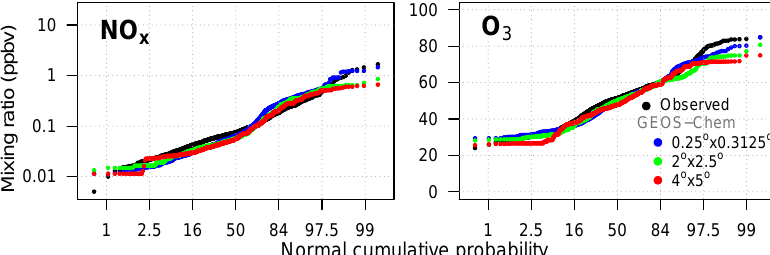
Figure 7. Cumulative probability distribution functions (CDFs) of NO x and ozone (O 3 ) concentrations in the lower free troposphere over the Southeast US (from mixed layer top to 4km altitude) during the SEAC 4 RS aircraft campaign. Observations are compared to GEOS- Chem model values at different resolutions sampled along the flight tracks over the Southeast US domain of Fig. 1. The x axis is a normal probability scale such that a normal distribution (ozone) or lognormal distribution (NO x ) would plot as a straight line.